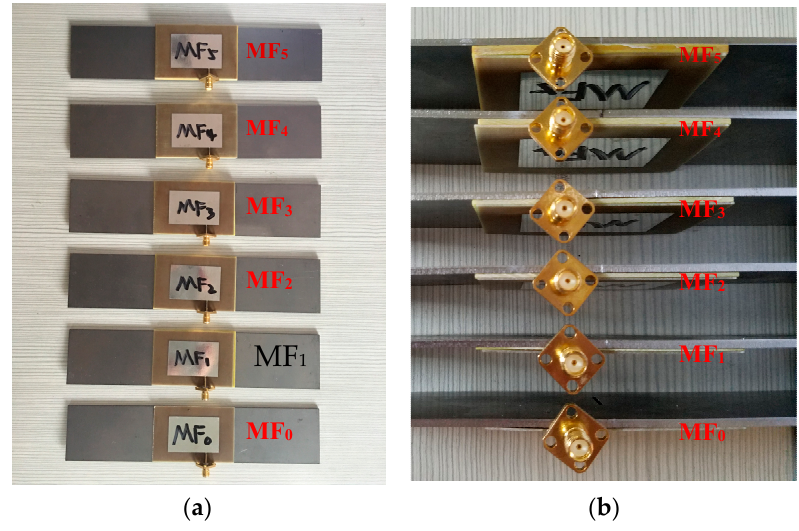
Figure 12. Specimens with different GFRP thicknesses. ( a ) Top view; ( b ) Side view.